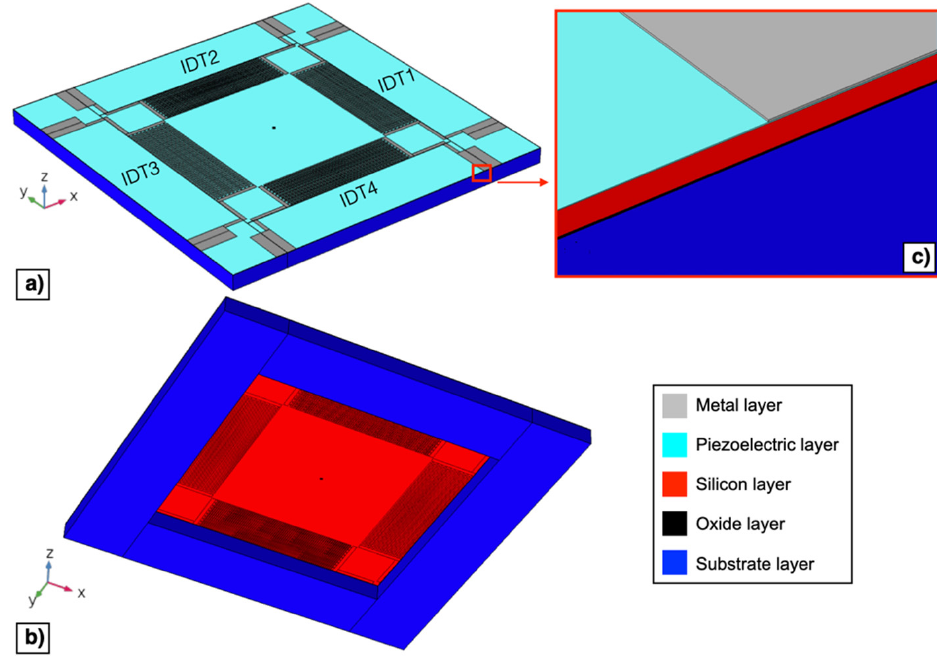
Figure 6. Top ( a ) and bottom ( b ) 3D model views of the proposed piezoelectric MEMS device. Enlarged image of the layers employed in the simulation model ( c ).